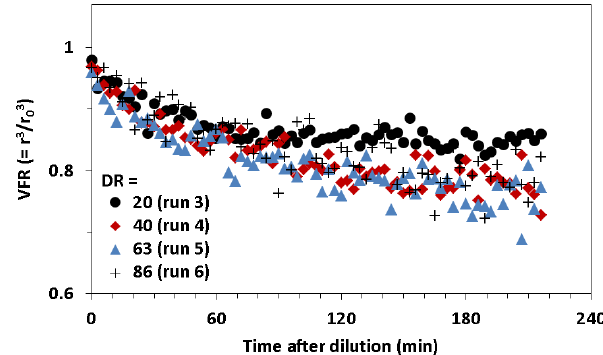
Figure 7. Volume fraction remaining (VFR) for SOA particles formed from the photooxidation of TMB as a function of time after